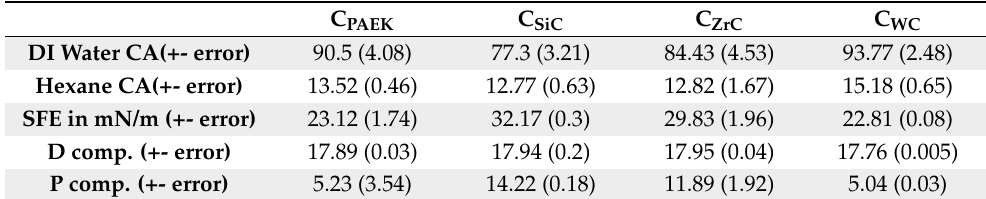
Figure 4. ( a ) Contact angles for NCs; ( b ) surface-free energy for NCs. Table 3. SFE, contact angle (CA) (DI water, hexane), and P and D